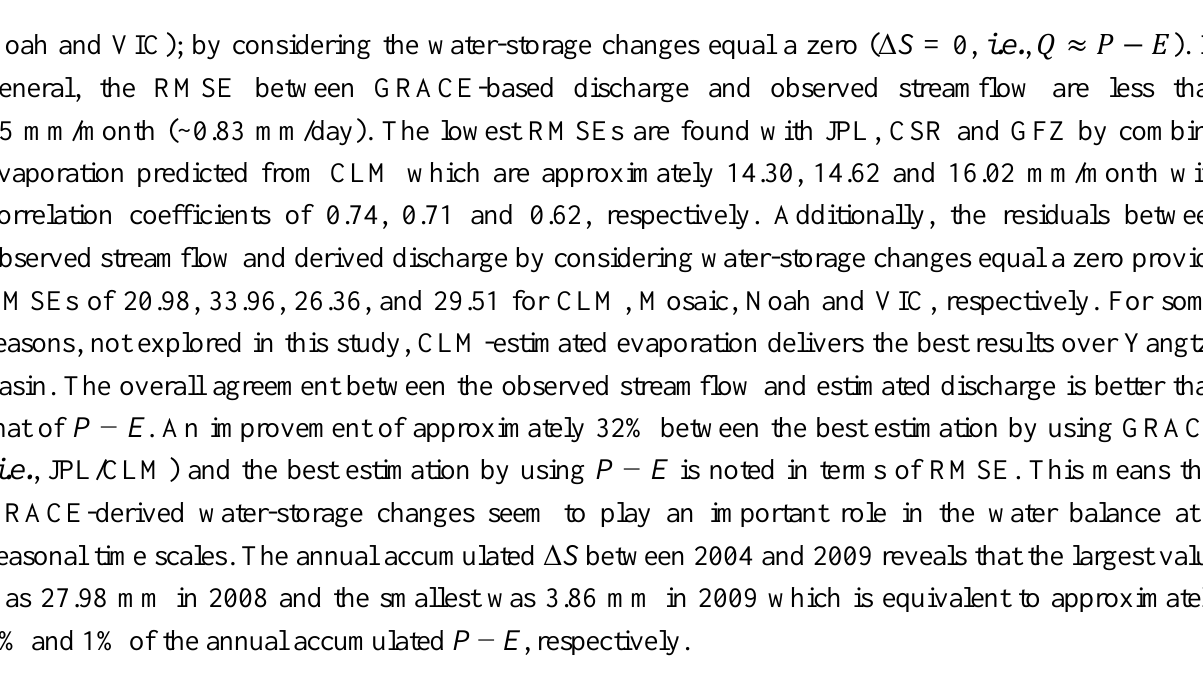
Figure 5. Taylor’s diagram of statistical comparison between the time series of observed streamflow (reference) at Datong hydrological station and estimated discharge